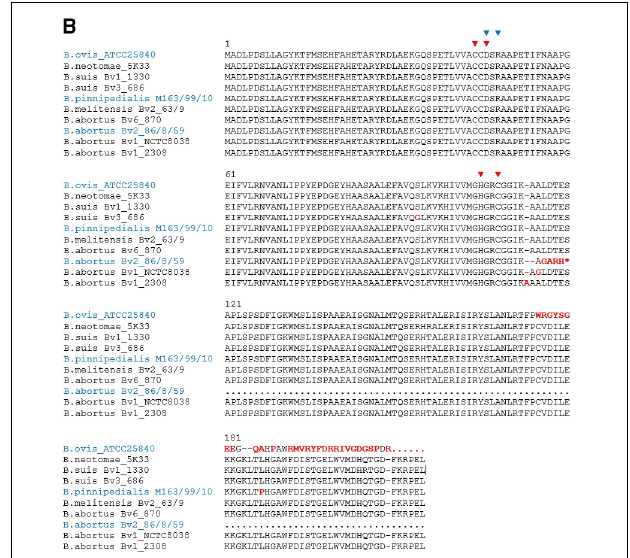
FIGURE 1 | Alignment of sequences of carbonic anhydrase (CA) II from representative Brucella isolates. The genomes shown here are the representative species for each of the clusters of identical sequences obtained from the 35 selected Brucella strains. Those clusters formed by species that are CO 2 dependent are shown in blue. (A) Partial DNA sequences, with nucleotides that differ from the consensus wild-type sequence highlighted in red, and (B) protein sequences, with amino acids that differ from the consensus wild-type sequence highlighted in red. Red triangles indicate the four zinc-binding residues, Cys42, Asp44, His98, and Cys101, and blue triangles the catalytic dyad